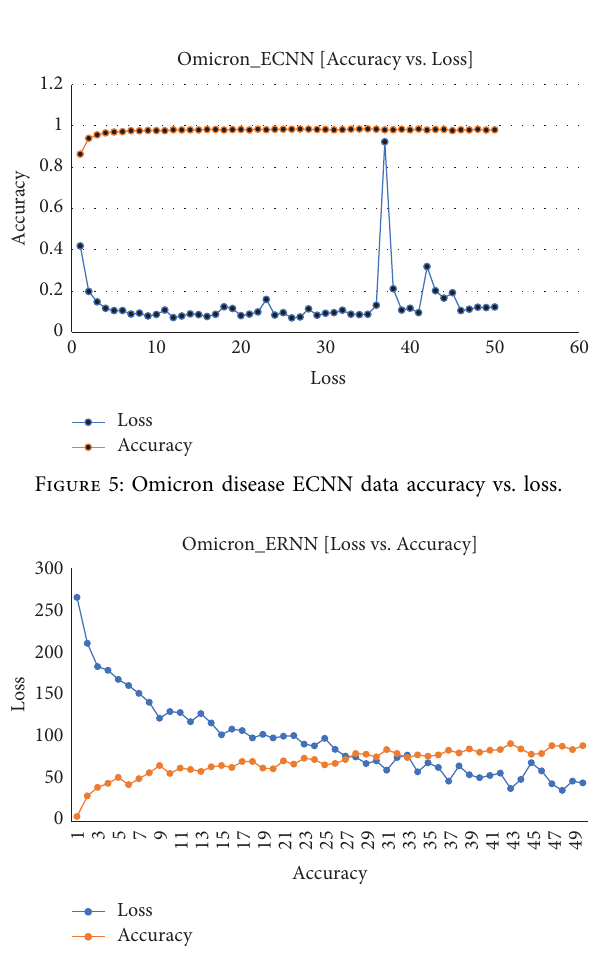
Figure 6: Omicron disease ERNN data accuracy vs. loss.